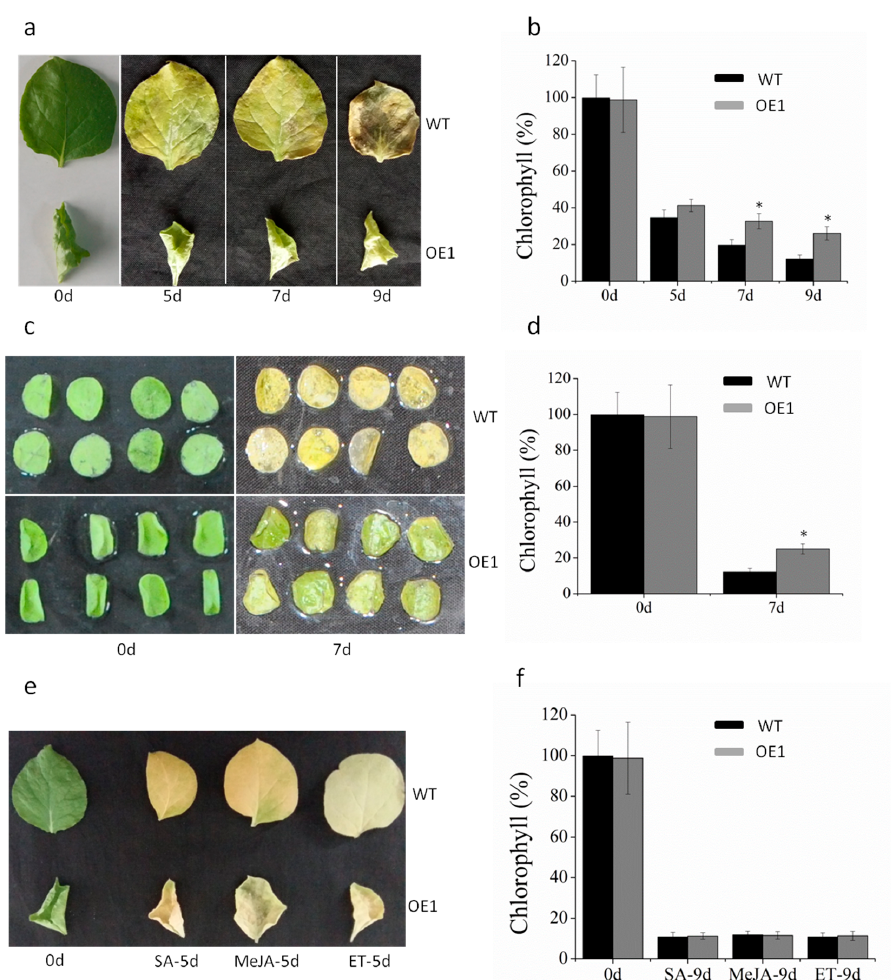
Figure 5. Leaf senescence induction by application of hormones to DRL1 -overexpressing transgenic tobacco plants. ( a , b ) Detached leaf senescence phenotypes of transgenic tobacco treated with abscisic acid ( a ) and determination of chlorophyll concentration ( b ). ( c , d ) Leaf senescence phenotypes of transgenic tobacco leaf disks treated with ABA ( c ) and determination of chlorophyll content ( d ). ( e ) Leaf senescence phenotypes of transgenic tobacco treated with salicylic acid, methyl jasmonate, or ethylene followed by determination of chlorophyll content ( f ). Bars represent mean ± SD with at least three biological replicates. Significant difference from the WT was confirmed by Tukey’s test ( * p < 0.05).